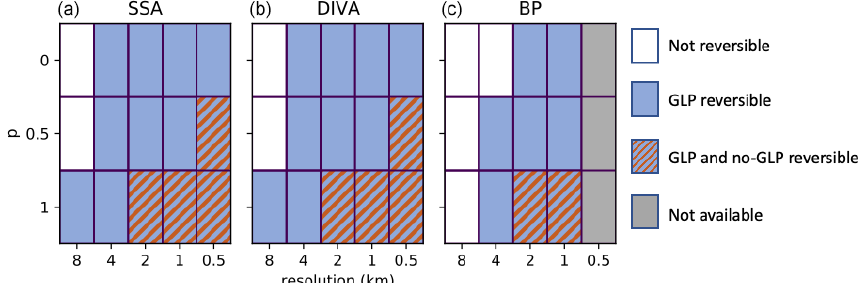
Figure 5. Results of grounding line reversibility tests as a function of resolution in the MISMIP3d P75R experiments for SSA (a) , DIVA (b) , and BP (c) and using p = 0 (top), p = 0 . 5 (middle), and p = 1 (bottom). Each experiment is not reversible (white), only reversible with a GLP (blue), reversible with and without a GLP (blue-brown striping), or not available (grey) because the run was not performed at that resolution. An experiment is considered reversible if the grounding line at the end of P75R retreats to within 4km of its unperturbed position at the end of experiment Stnd.